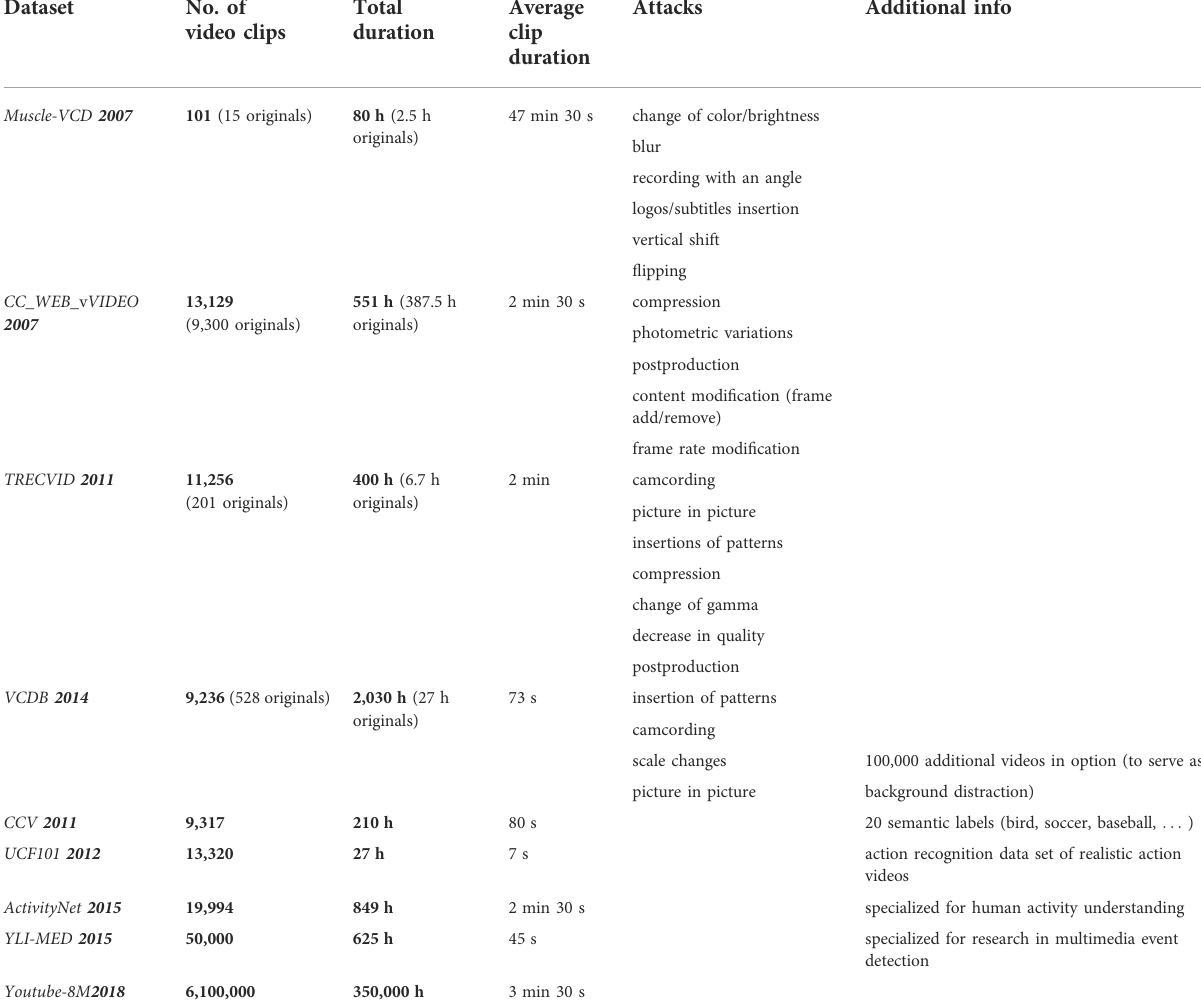
TABLE 1 Examples of datasets processed for fi ngerprinting evaluation. The lower part (last 5 rows) corresponds to corpora processed by fi ngerprinting method exploiting NN.